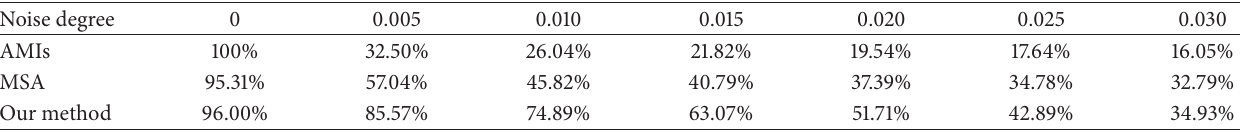
Table 3: Classification accuracies of AMIs, MSA, and the proposed method for images in Figure 6 in case of affine transformation and different intensities of Gaussian